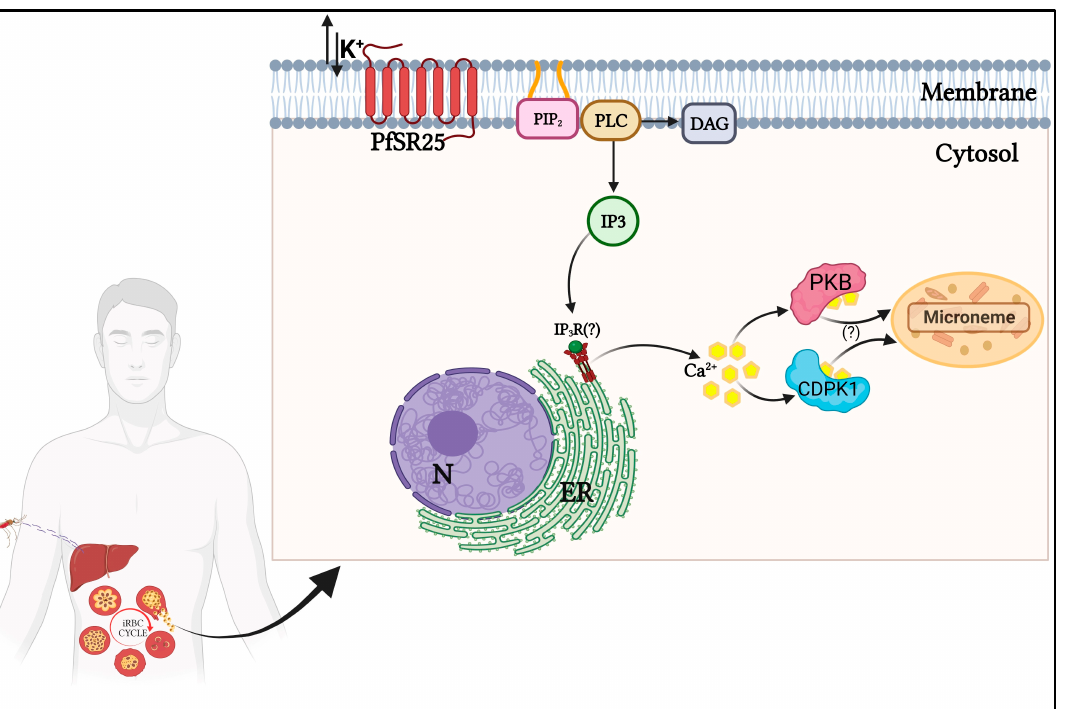
Figure 1. Schematic representation of the signaling pathway involving K + in Plasmodium spp. during its asexual developmental phases. In the erythrocytic stage, the exposure of P. falciparum to variations in [K + ] is perceived by the GPCR-like PfSR25, which transmits the signal through the activation of phospholipase C (PLC). After PLC activation, inositol 1,4,5-triphosphate (IP 3 ) and diacylglycerol (DAG) are formed. IP 3 activates an IP 3 receptor (hypothetical IP 3 R) to release calcium (Ca 2+ ) from the endoplasmic reticulum (ER). The increase in cytosolic levels of Ca 2+ activates the Ca 2+ -dependent protein kinases CDPK1 and PKB, leading to the release of microneme proteins essential for the infection of new erythrocytes. Created with BioRender.com.